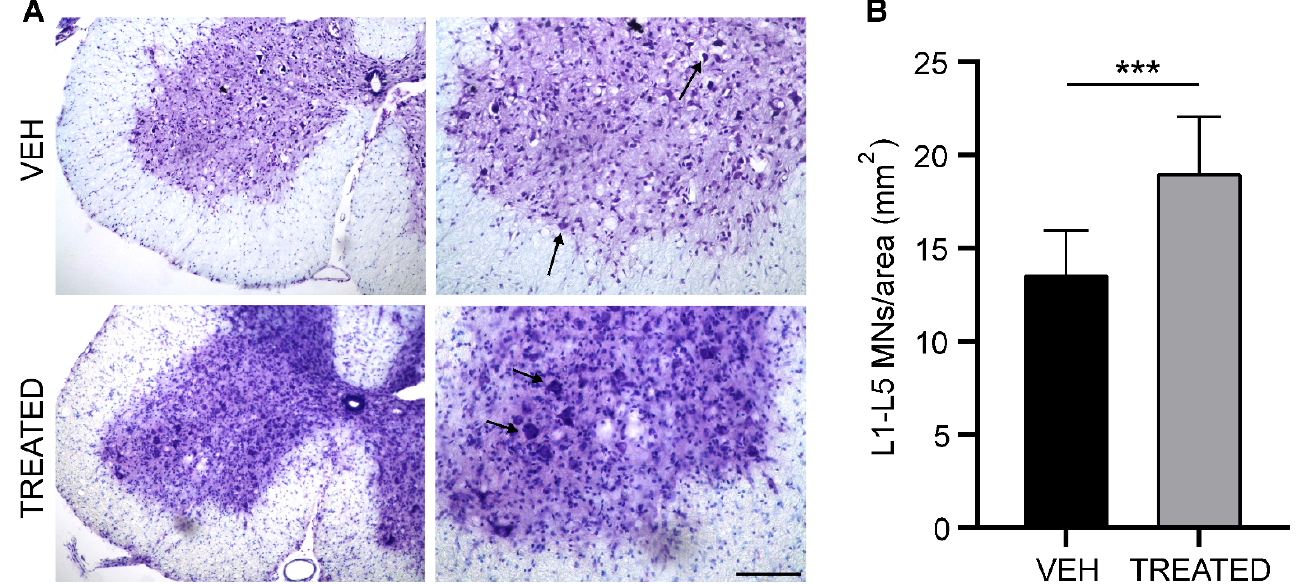
Figure 4. The MN count in the lumbar tract of the spinal cord (L1- L5): ( A ) Nissl staining on the L3 lumbar segment of the spinal cord at the end stage of the disease in VEH and TREATED groups. The arrow shows stained MN; ( B ) The graph shows the MN number/area in the L1-L5 tract of both the TREATED and VEH groups. In the TREATED group, there was a significant increase in MN survival compared to the VEH group ( p = 0.0002; n = 10 VEH, 12 TREATED). Images on the left panel have a magnification of 10×, which images on the right panel have a magnification of 20× (scale bar = 100 μ m). Data were analyzed by the Student t -test, expressed as mean ± SEM. *** p <